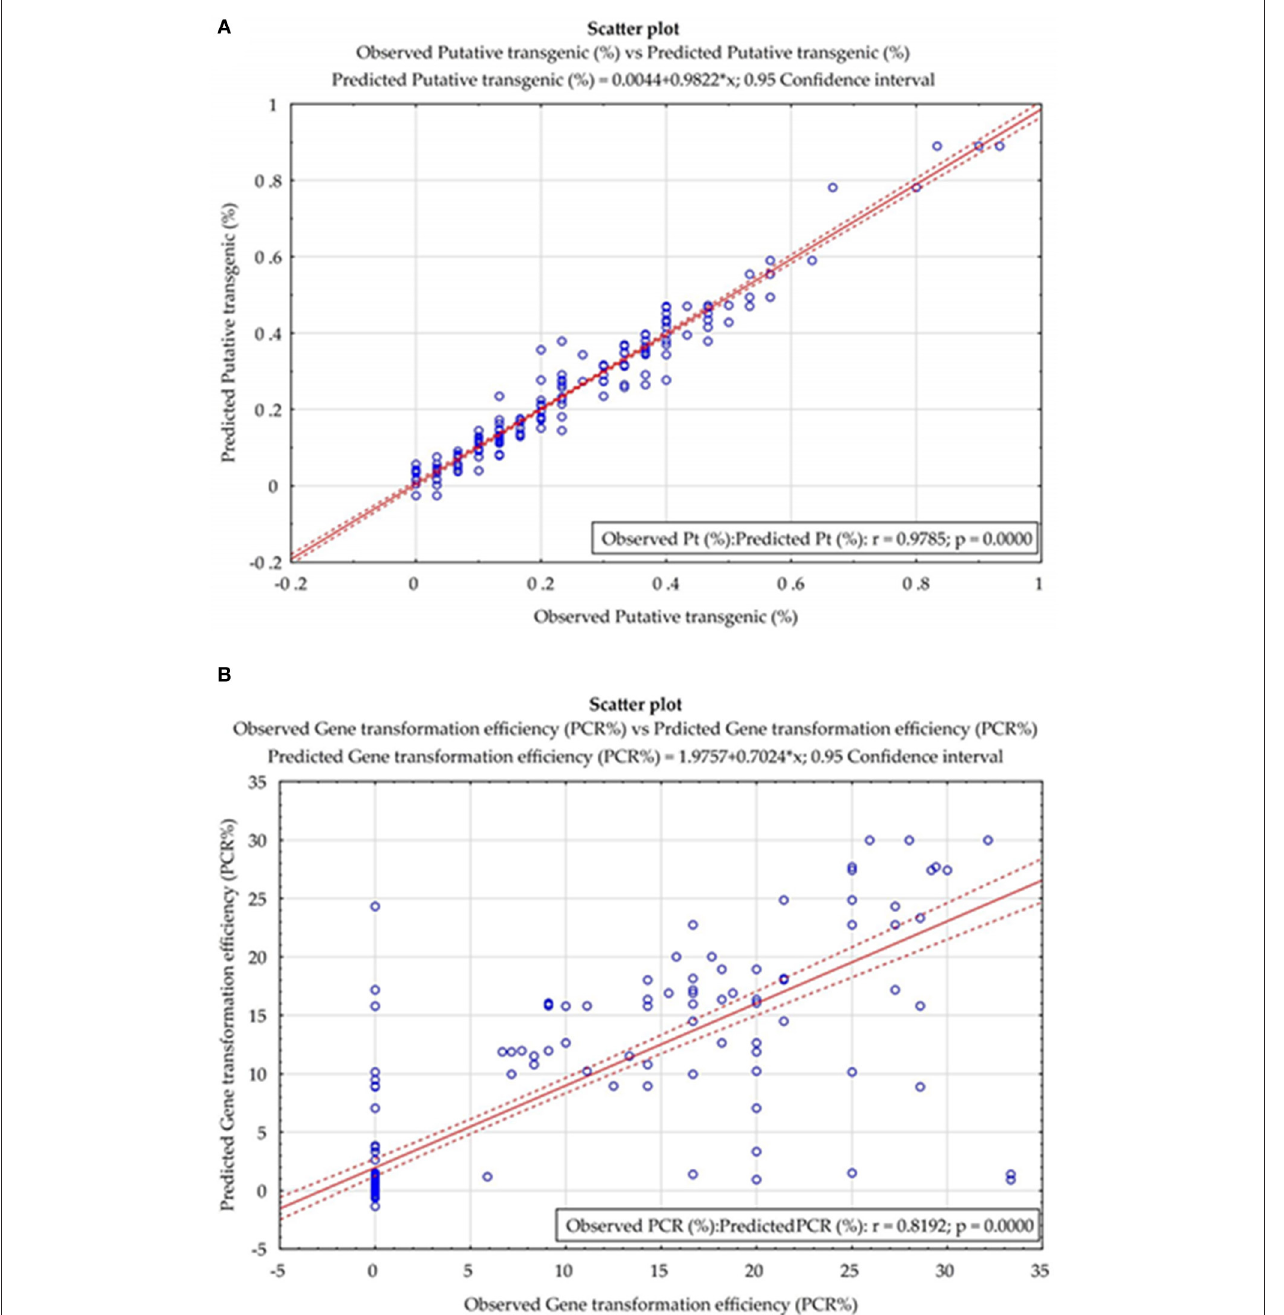
FIGURE 5 | The scatter plot of the observed vs. the predicted values of (A) the percentage of putative transgenic tobacco plants and (B) the percentage of PCR-verified transgenic tobacco plants in the fitted ANN models.